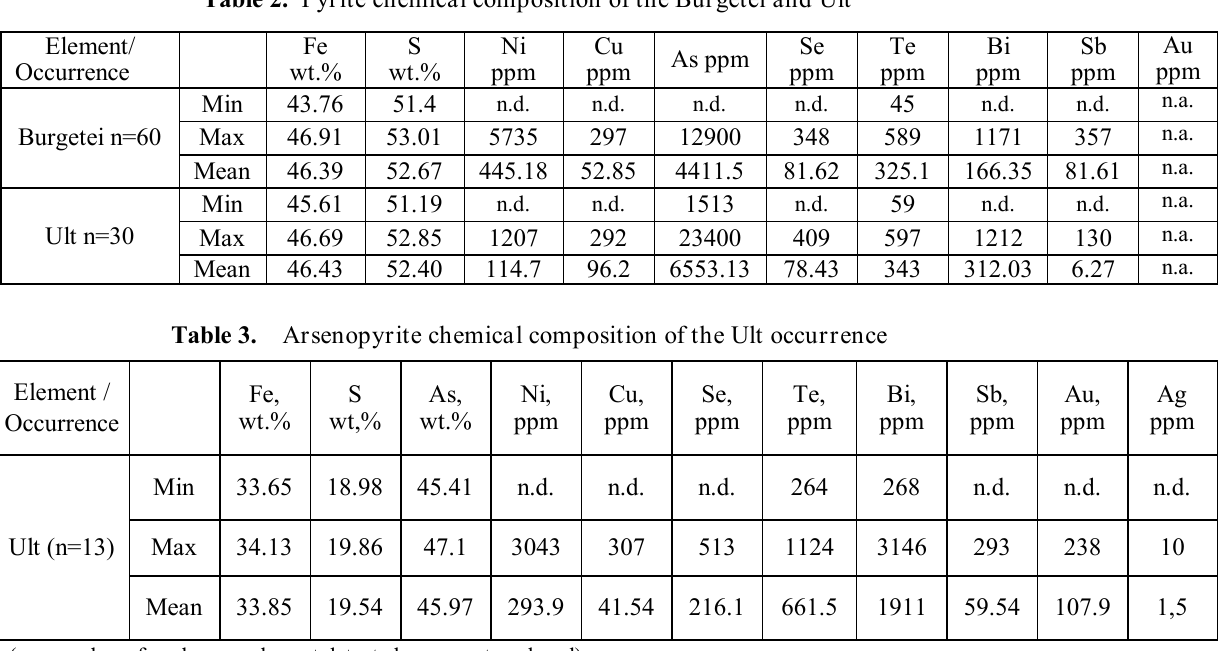
Table 2. Pyrite chemical composition of the Burgetei and